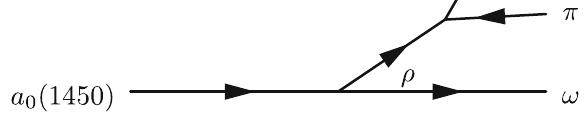
(cid:23)( a ( 1450 ) → πη) = 14 . 7 MeV, which gives a 0